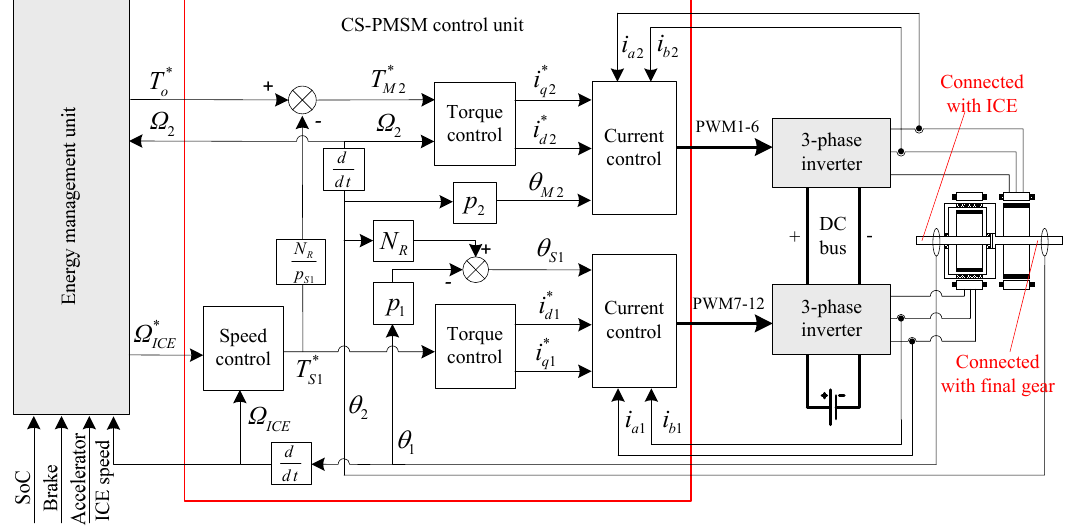
Figure 4. Control diagram of the flux-modulated CS-PMSM